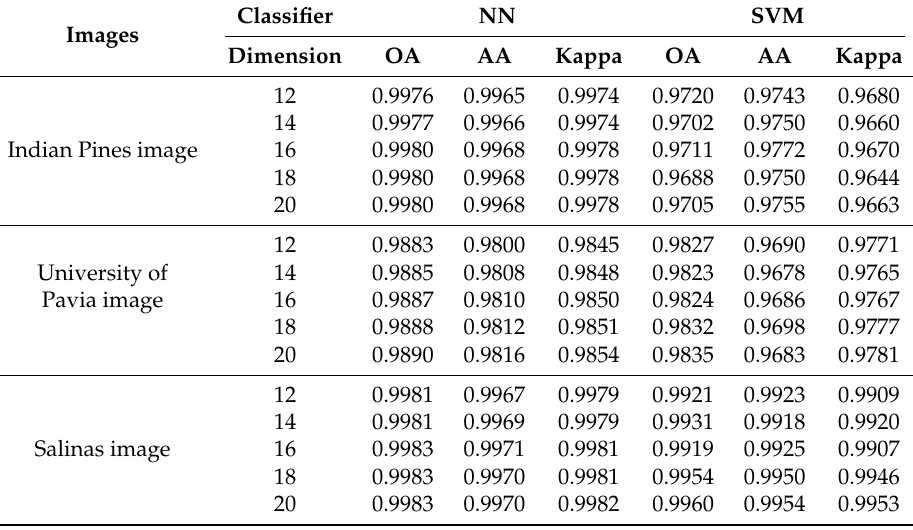
Table 8. Classification accuracy of the BLRDA method with different reduced